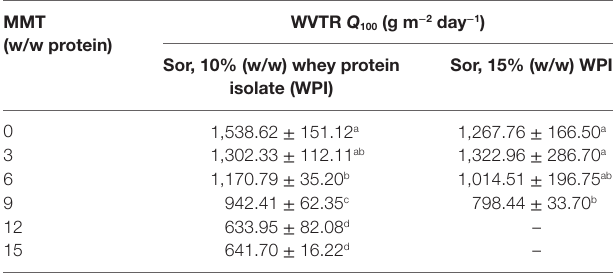
Columns with different letters are significantly different (p ≤ 0.05) for each dataset. Measurement conditions were 23°C and 85% → 0% r.h. Values represent mean ±